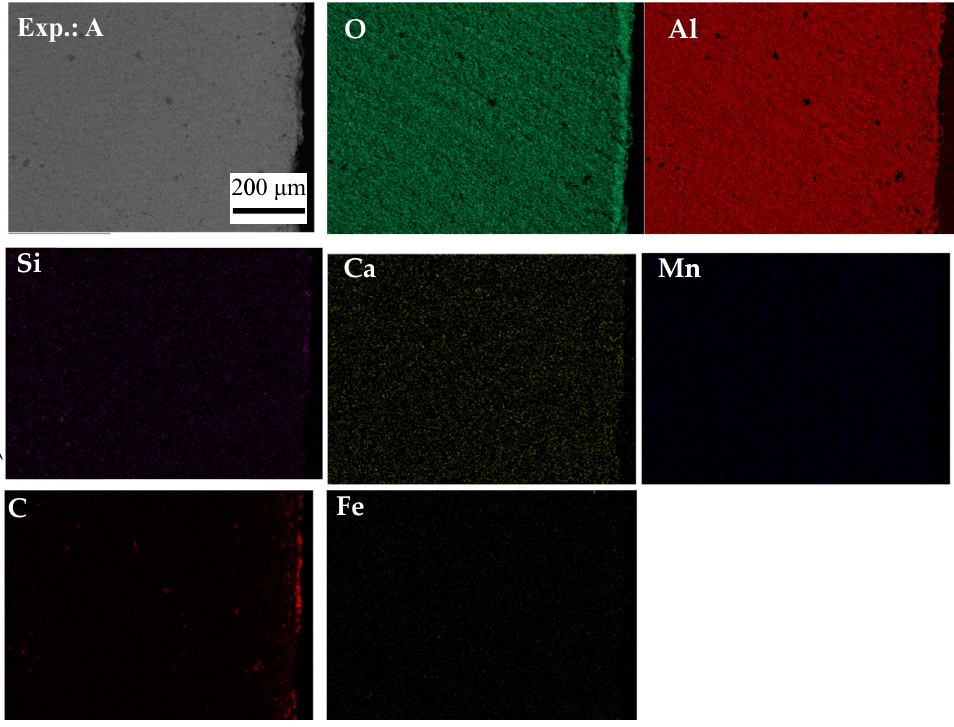
Figure 7: Element mapping results of Al 2 O 3 crucible.